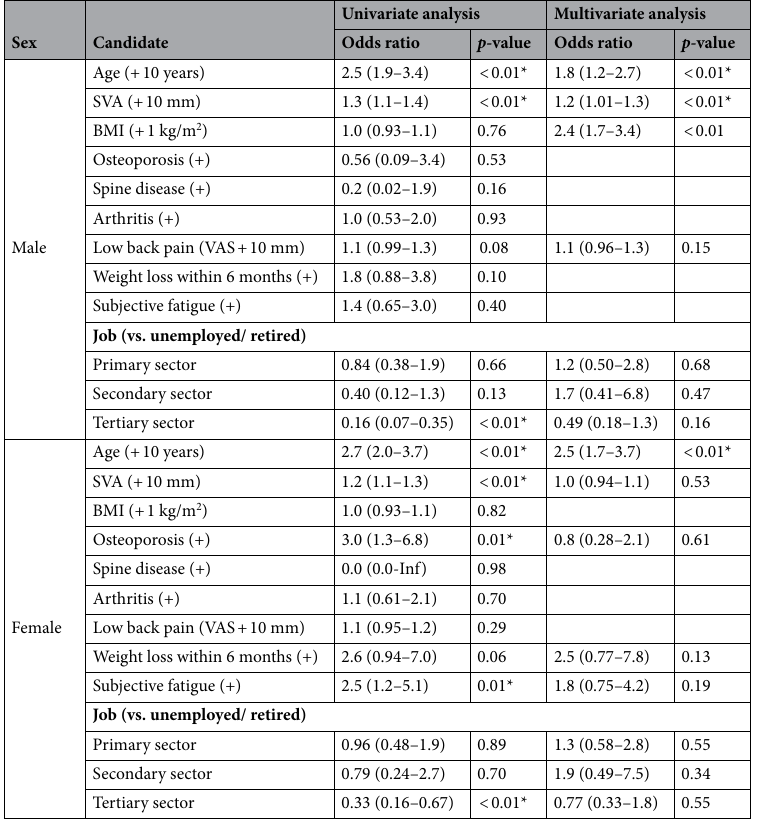
Table 2. Univariate and multivariate analyses on the association of cognitive impairment with age, spinal balance, and other candidate factors. Odds ratios are presented with the 95% confidence interval. SVA